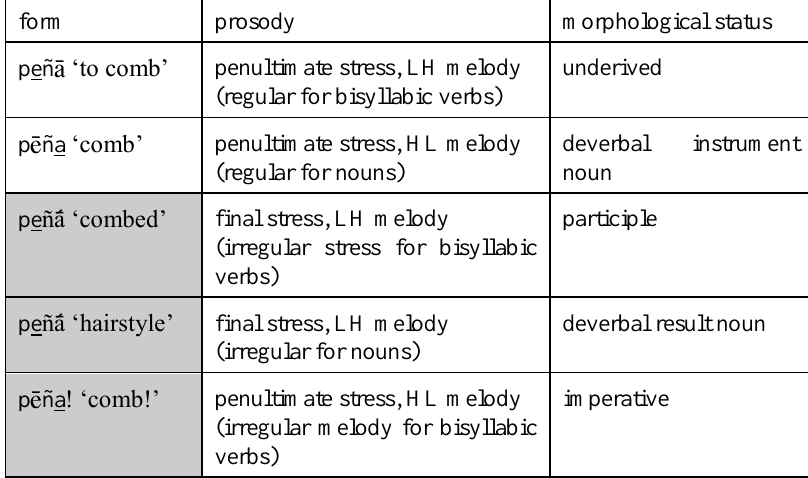
Table 6. Derivation from input peña ‘to